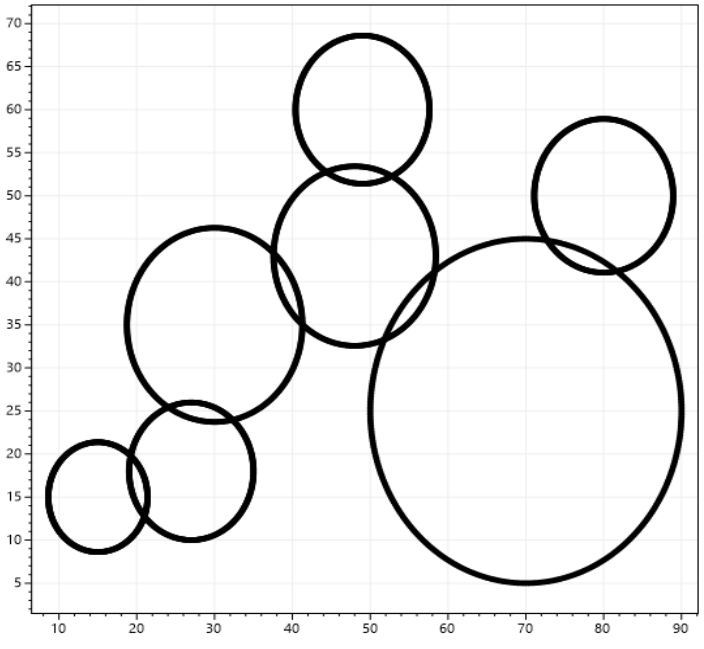
Figure 2. Result network.